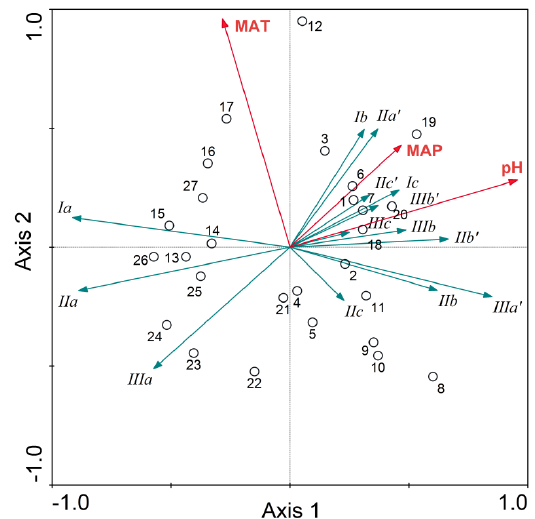
Figure 4. RDA triplot showing the relationship between 5- and 6-methyl brGDGT percentages, MAT, MAP and soil pH from the QTP. Numbers in the plot correspond to the soils in the Supplement (Table S1). The first and second axes explained 65.2 and 6.1% of the variance,